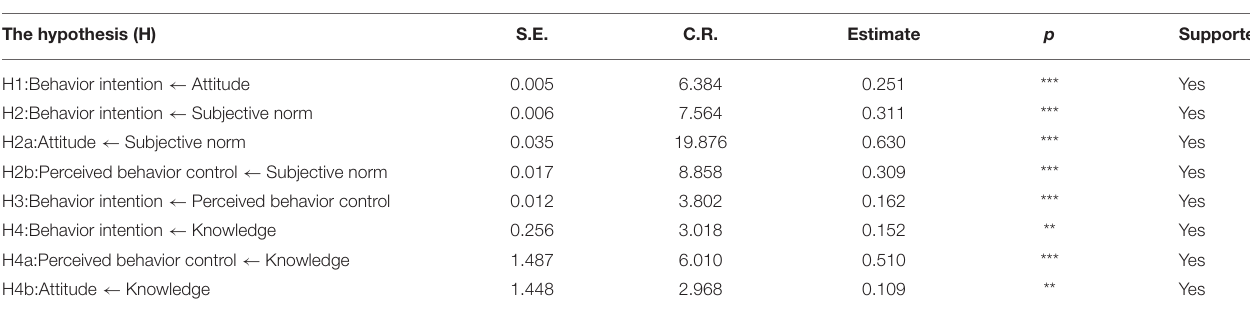
TABLE 4 | Results of structural equation modeling